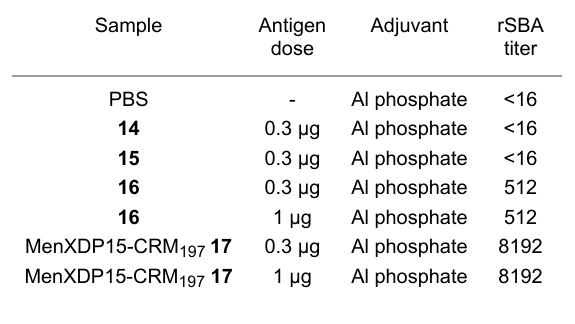
Table 2: rSBA titers of sera from immunized